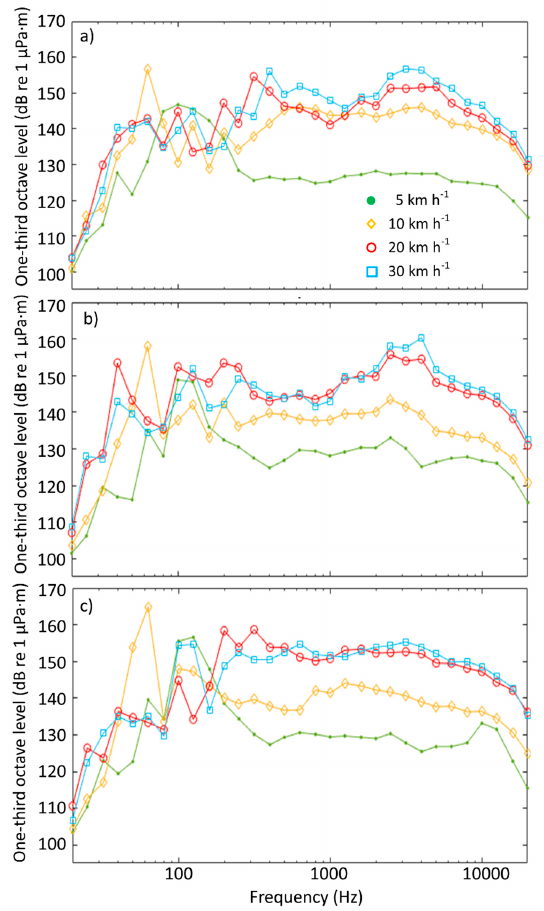
Figure 7. One-third octave radiated noise levels for ( a ) Primrose , ( b ) Macquarie, and ( c ) Kirsty K , at speeds of 5, 10, 20 and 30 km h − 1 (green circles, beige diamonds, red circles and blue squares, respectively). Linear regression determined one-third octave band PLs decreased with increasing frequency (Figure 8) from between 20 and 40 at frequencies below 50 Hz, to between 10 and 25 for frequencies between 50 and 2000 Hz. Above 2000 Hz, the propagation loss coefficients split with the vessels travelling at 5 km h − 1 that exhibited little energy at these frequencies having coefficients of <10 (Figure 8, dots at >2000 Hz) and models for vessels with greater power and faster speeds displaying higher coefficients of 5 to 15 (Figure 8, red and green lines at >2000 Hz). Applying these frequency- dependent PL coefficients to the one-third octave band RLs produced ASL estimates higher than those derived using a single frequency-independent PL coefficient (Supplementary information).